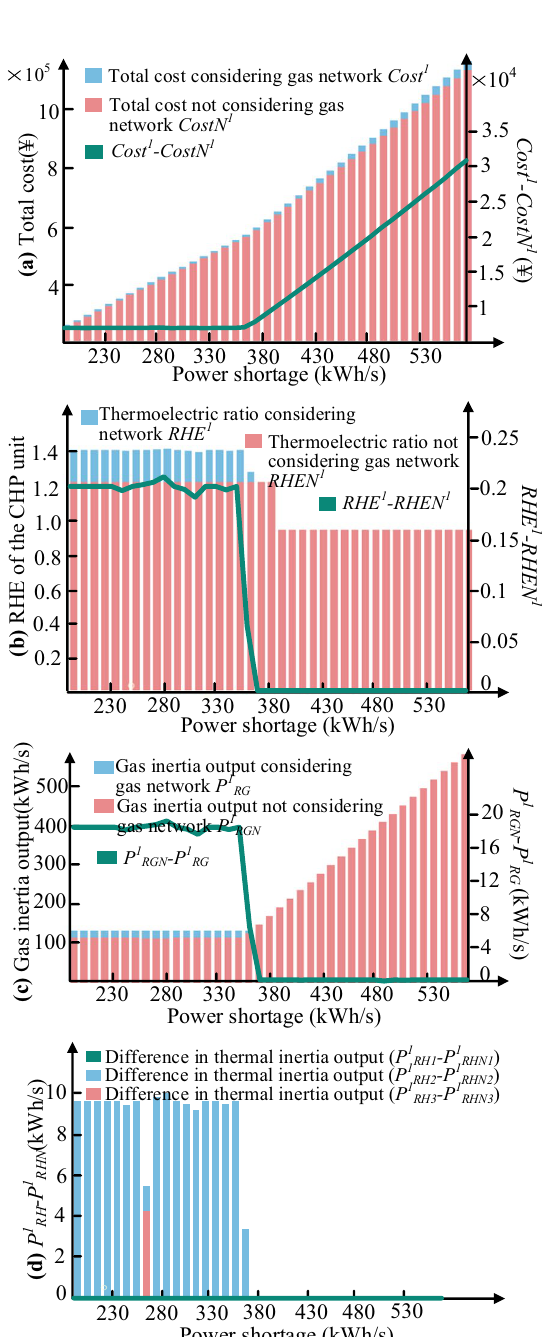
Fig. 10 Comparison results with power shortages at L 1